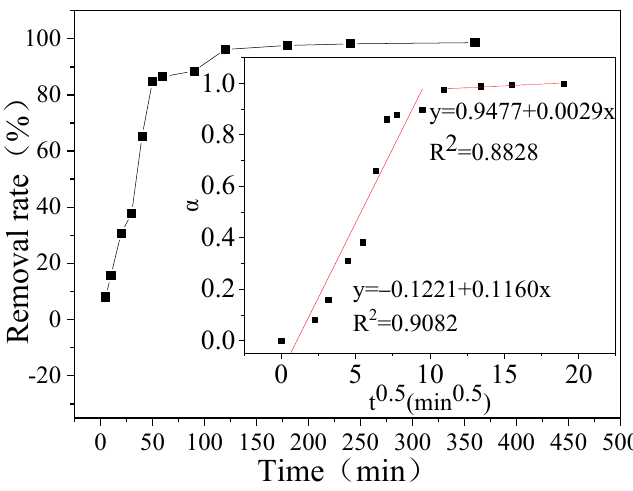
Figure 2. Effect of the reaction time on As(V) removal. Right inset shows modeling of the kinetics of arsenic adsorption onto ZVI by the Boyd